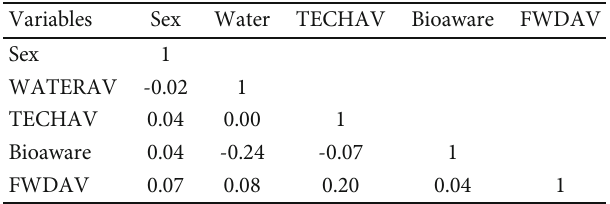
Table 4: Contingency coe ffi cient for dummy explanatory variables.